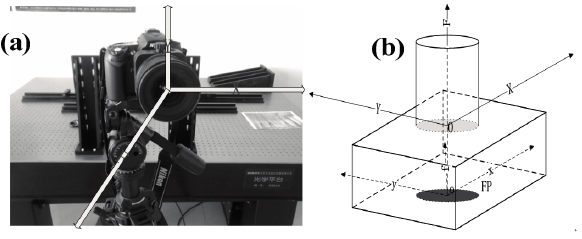
Figure 7. ( a ) TSC of the prototype system and ( b ) the defined coordinates.